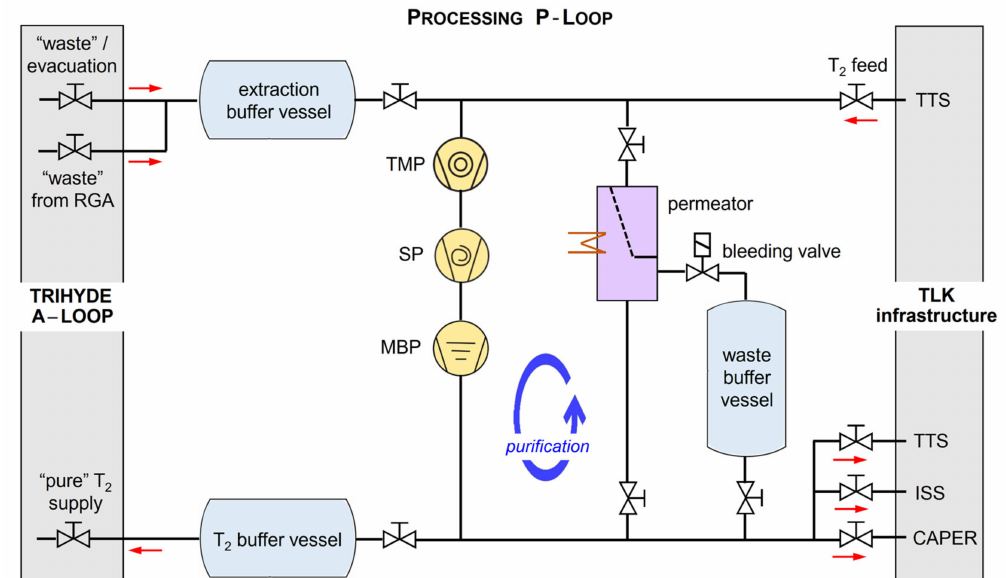
Figure 4. Schematic of the processing segment of TRIHYDE—the P-Loop. Gases enter the loop either from the TTS tritium gas supply or are “waste” gases from the A-loop and exit the loop either to the A-loop or the TLK infrastructure units. The gas (mixtures) are moved and/or compressed by a series of pumps; TMP = turbomolecular pump; SP = scroll pump; MBP = metal bellows pump. Optional to simple gas distribution, the P-loop incorporates the capability of gas cleaning by circulation through a permeator. For details, see